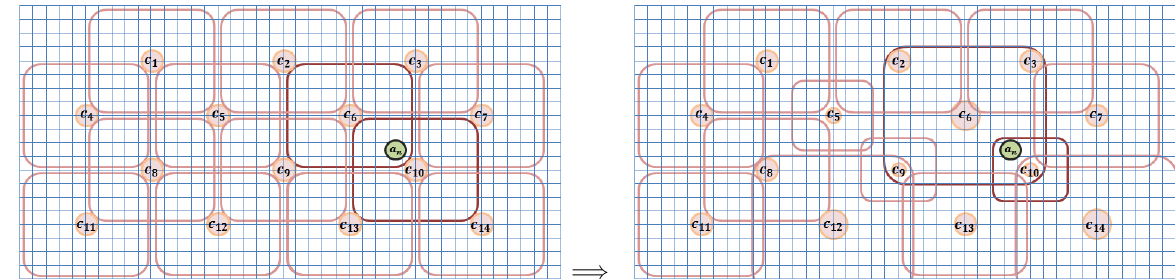
Figure 2: A graphical representation of overlapping areas of coverage of “cells” (processing units). In the above example, cells c 6 and c 10 can both process signal a and with all cells operating at the same focus level ( left ), both of them do. In that case, the decision which cell n processes signal a is inconsequential and simply subject to agreement between c n tion, then the processing cell has to focus (narrow its coverage), which inevitably results in reducing the number of signals this cell can continue to process ( right ). To ensure continuous processing of all signals, other cells have to assist by taking on some of the otherwise or- phaned signals. This can have a ripple effect, affecting even cells further away. Note: we consider the (more diflcult) view where all signals processed by a cell receive equal amounts of processing power but the approach also works if this is not the